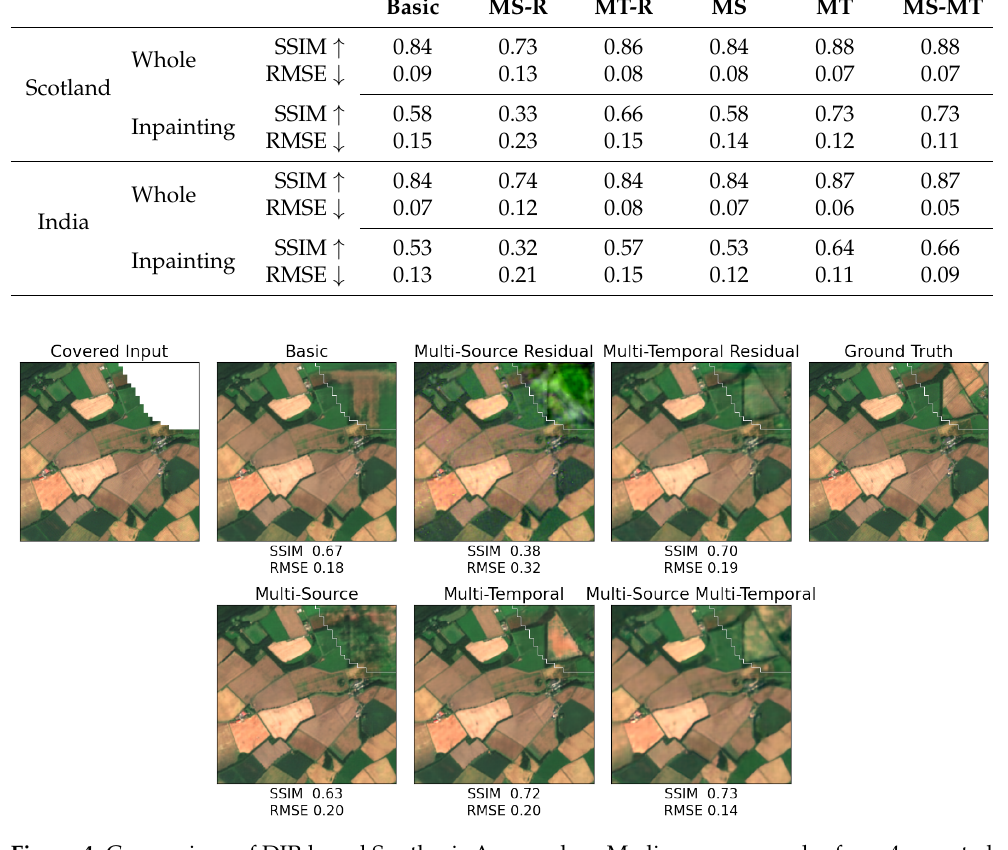
Figure 4. Comparison of DIP-based Synthesis Approaches. Median score samples from 4 repeated runs are shown. Metric values are given for the inpainting region.